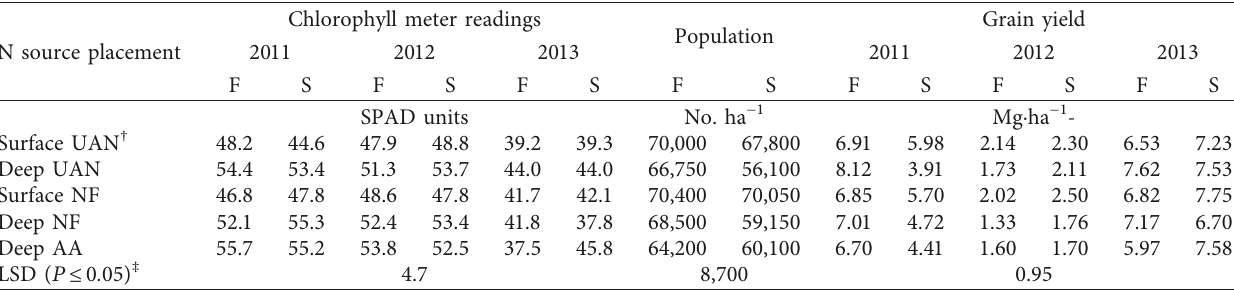
† Abbreviations: SorcPlac, source/placement. ‡ Numbers in bold represent Fisher’s protected least significant difference at P ≤ 0 . 05. Table 4: Corn SPAD, plant population, and grain yield response to nitrogen sources/placements at 84kg · N · ha − 1 . Data were combined over factors or years in the absence of a significant interaction. Surface treatments were no-tillage with surface applied nitrogen and deep treatments were strip tillage with deep banded nitrogen